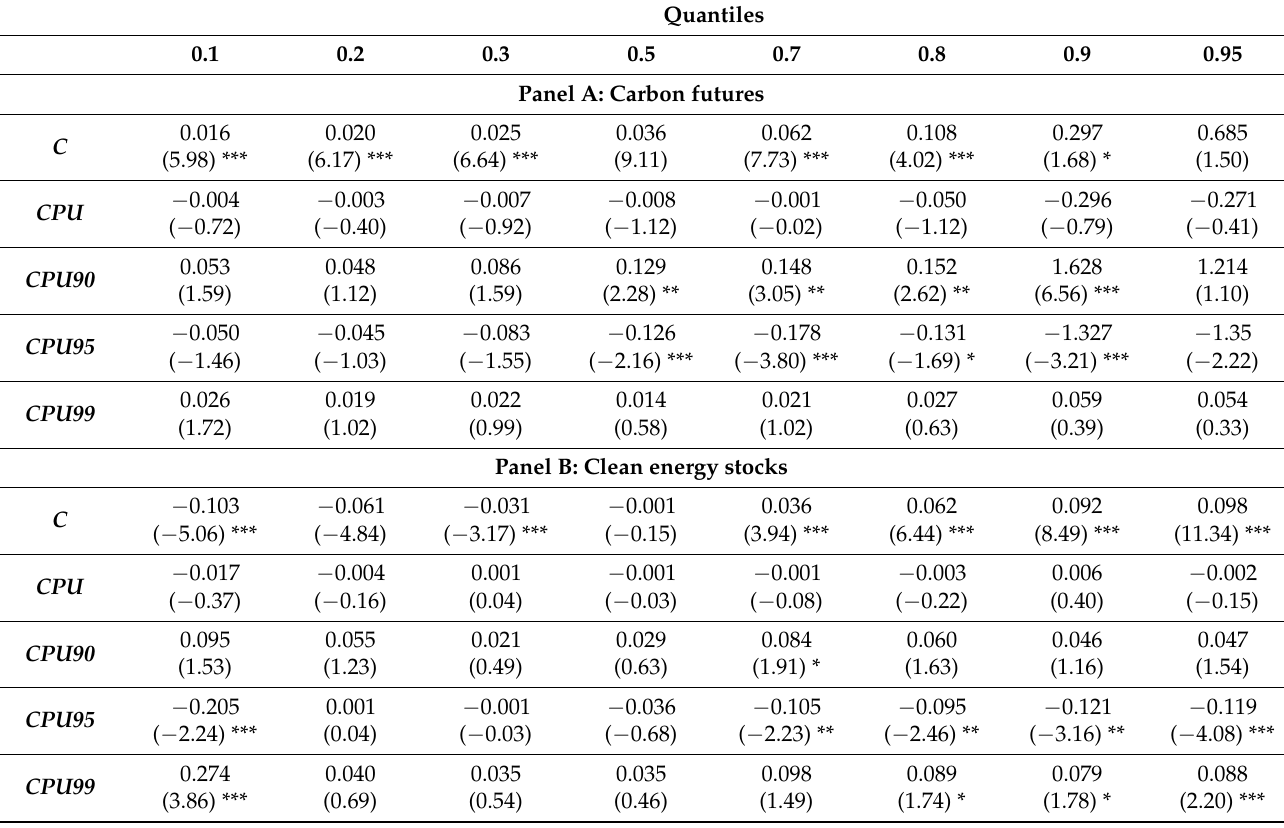
Table 4. Quantile regression with dummy for sub-sample: prior-Paris Agreement of 2016.